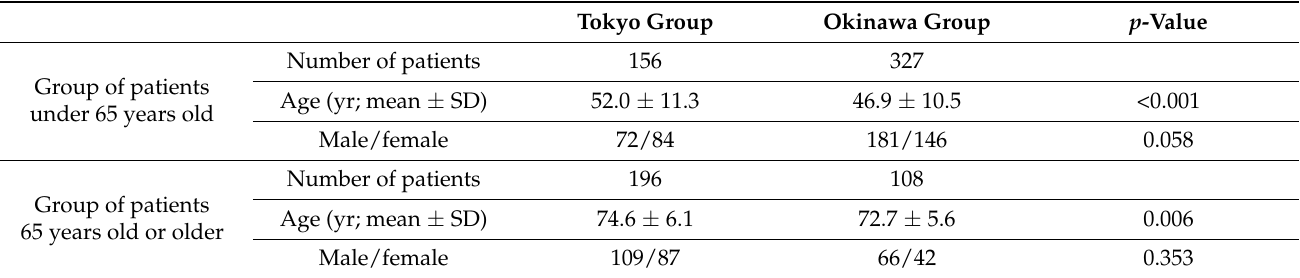
Table 2. Baseline characteristics of the patients under 65 years old and patients 65 years old or older.